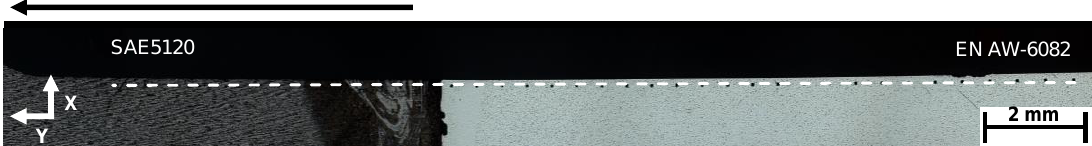
Figure 6. Metallographic cross section of the measured surface of the steel–aluminium alloy welds with visible hardness indentations (dashed line: course of the measurements).